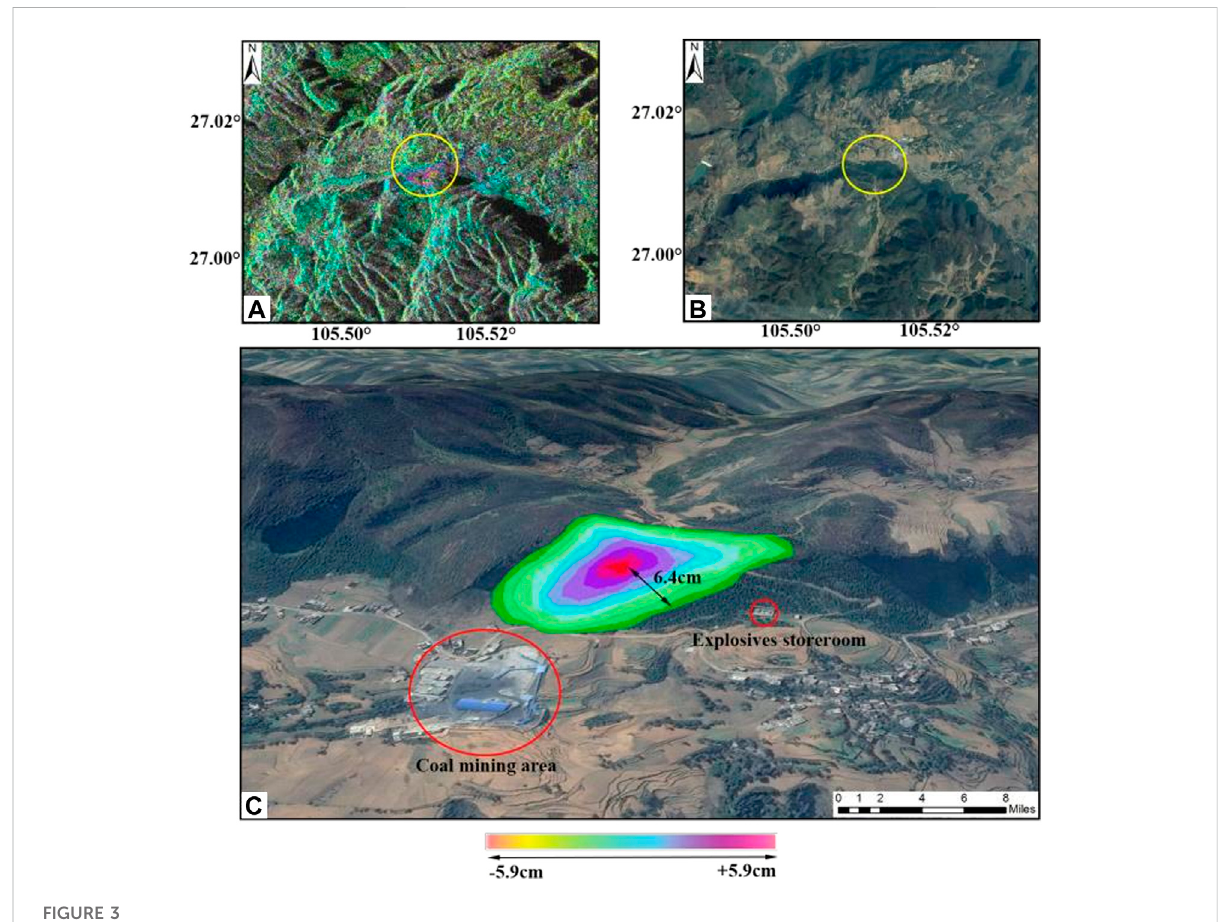
FIGURE 3 The DInSAR Yinjiazhai village